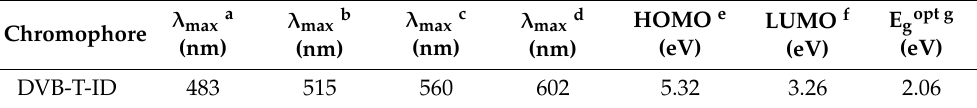
Table 1. Thermal, optical and electrochemical parameters of the synthesized DVB-T-ID OSM. λ max Chromophore